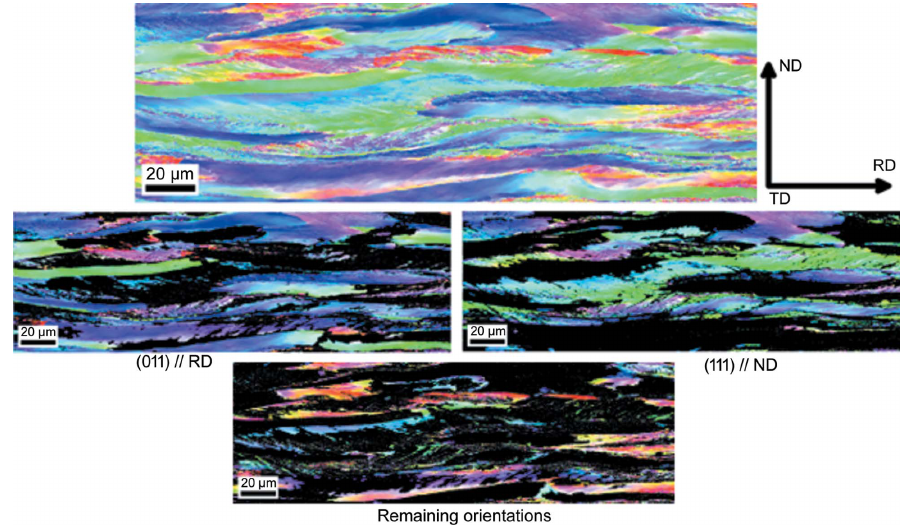
Figure 17 EBSD maps for the cold-rolled sample R75, for the partitions created to analyse the microstructure as a function of texture. For verifying the results obtained from XRD, three partitions were created: orientations along the (cid:7) -fibre (011) // RD, orientations along the (cid:6) -fibre (111) // ND and all remaining